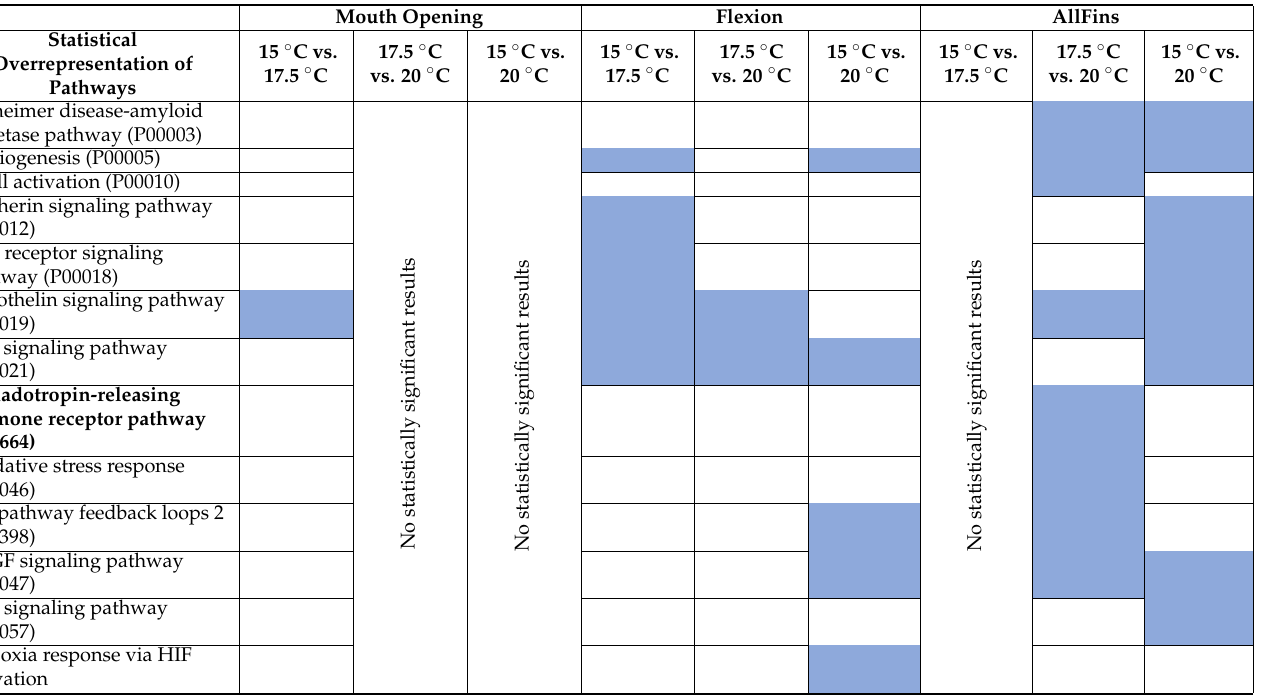
Table 2. Panther Pathway analysis of putative miRNA target